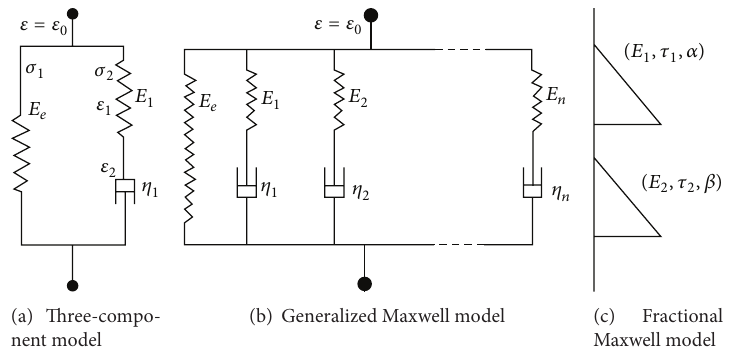
Figure 5: Several viscoelastic